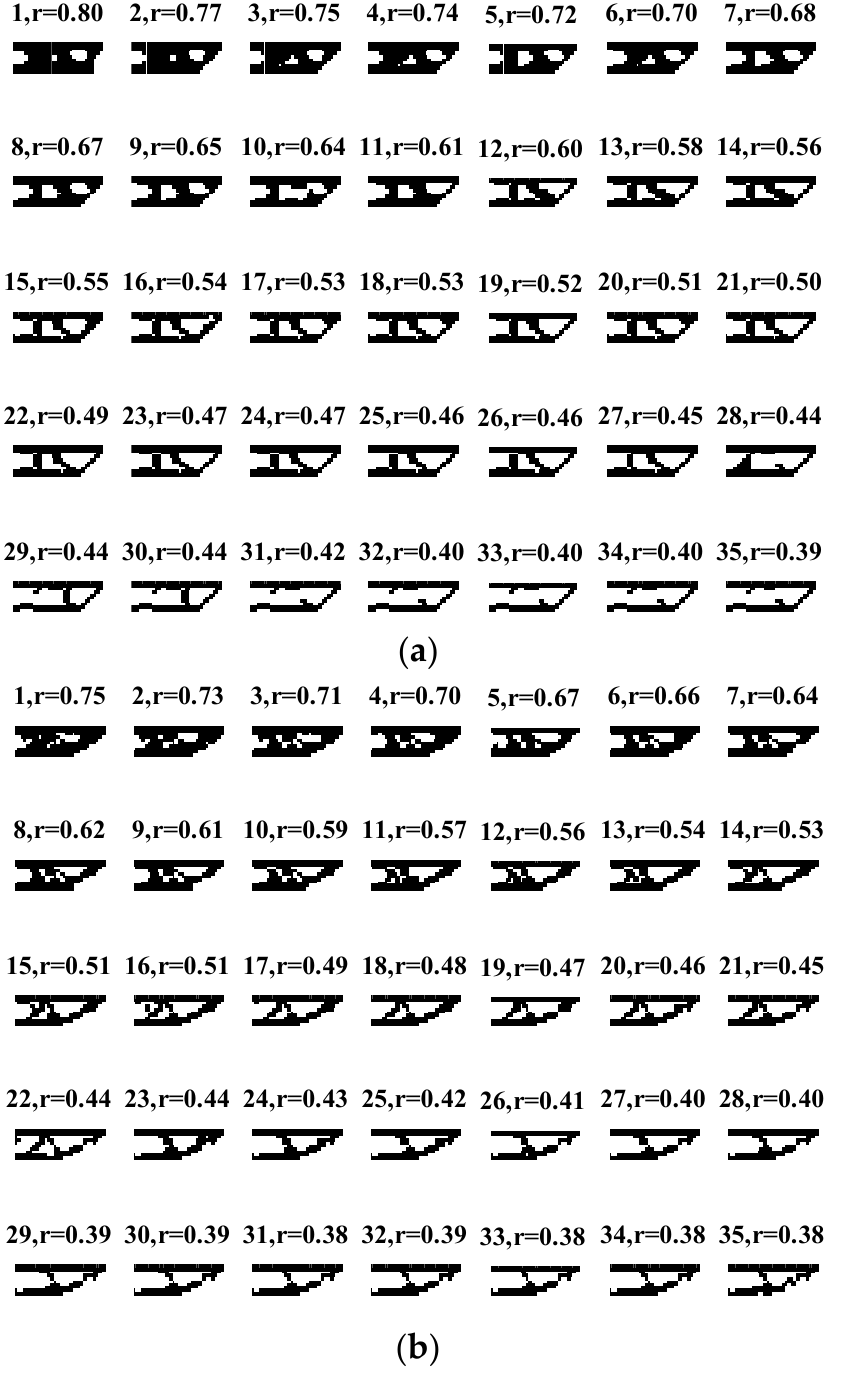
Figure 4. Topologies of MOP1: ( a ) OMPBIL with multi-grid; and ( b ) MPBIL without multi-grid.